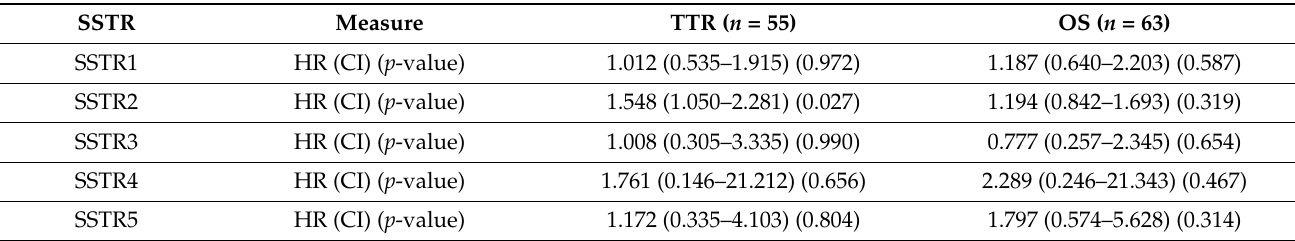
Table 5. Association between SSTRs expression and overall survival (OS) or recurrence (TTR) from univariate Cox regression analyses. Significant results marked in